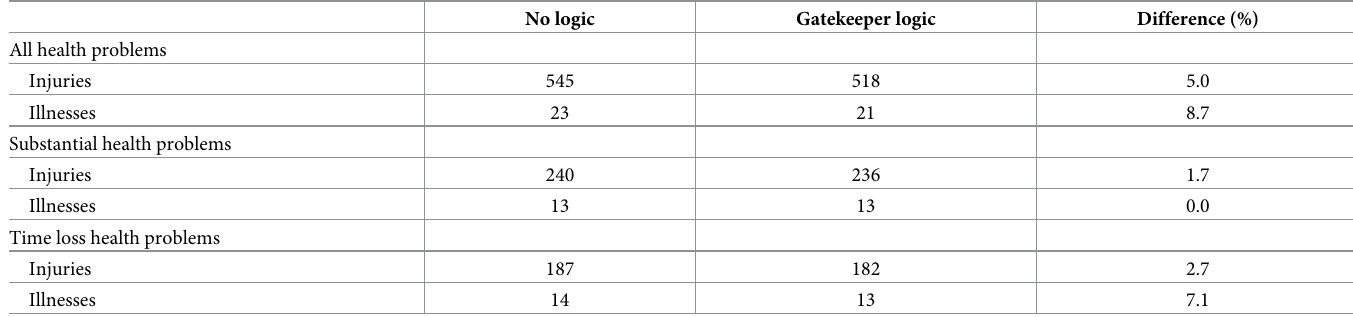
Table 3. Comparison of the number of health problems identified with and without the application of gatekeeper logic to question 1 in Japanese